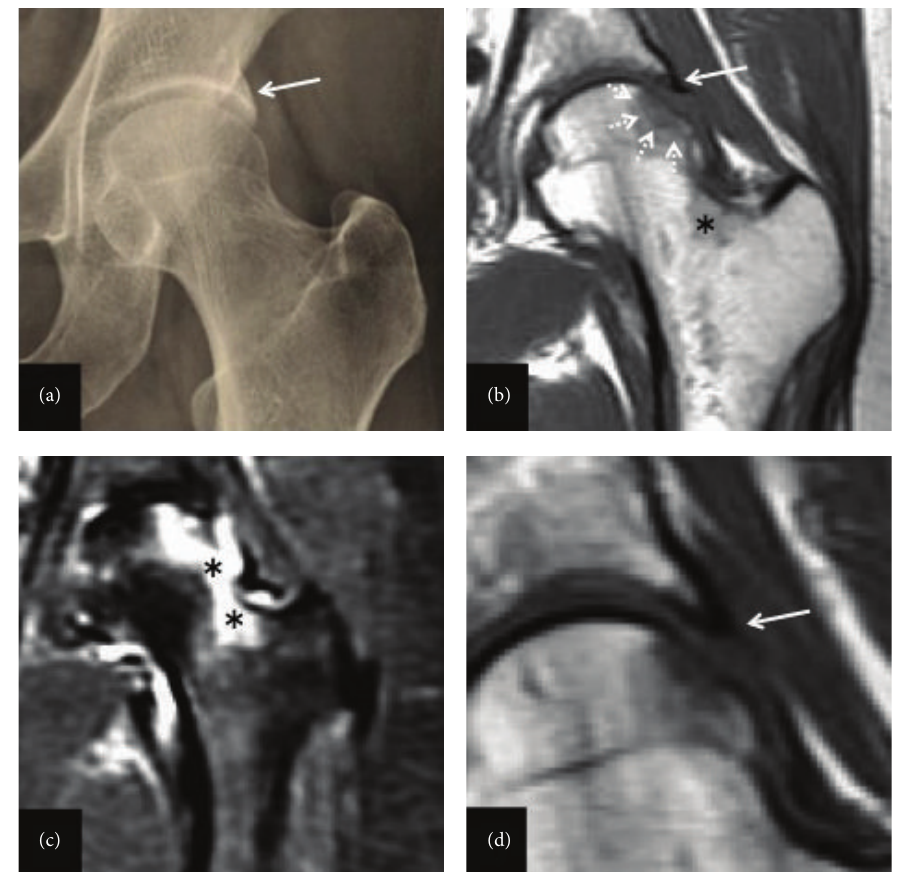
Figure 1: Initial radiograph and magnetic resonance imaging (MRI) of the left hip. (a) Anteroposterior view of the left hip shows acetabular overcoverage due to extended lateralization of the acetabular margin (white arrow). (b) T1-weighted image shows bone marrow edema with diffuse low intensity expanding from the lateral aspect of the femoral head to the intertrochanteric area. An irregular, serpentine, low intensity band (white dotted arrow) is present in the subchondral area. (c) Short-tau inversion recovery (STIR) image shows high signal intensity corresponding to the area of low intensity in (b). Black asterisks indicate the bone marrow edema of the femoral head and intertrochanteric area. (d) No apparent labral tear at the extended rim was observed but the labrum was relatively small and thin on the T1-weighted image (white